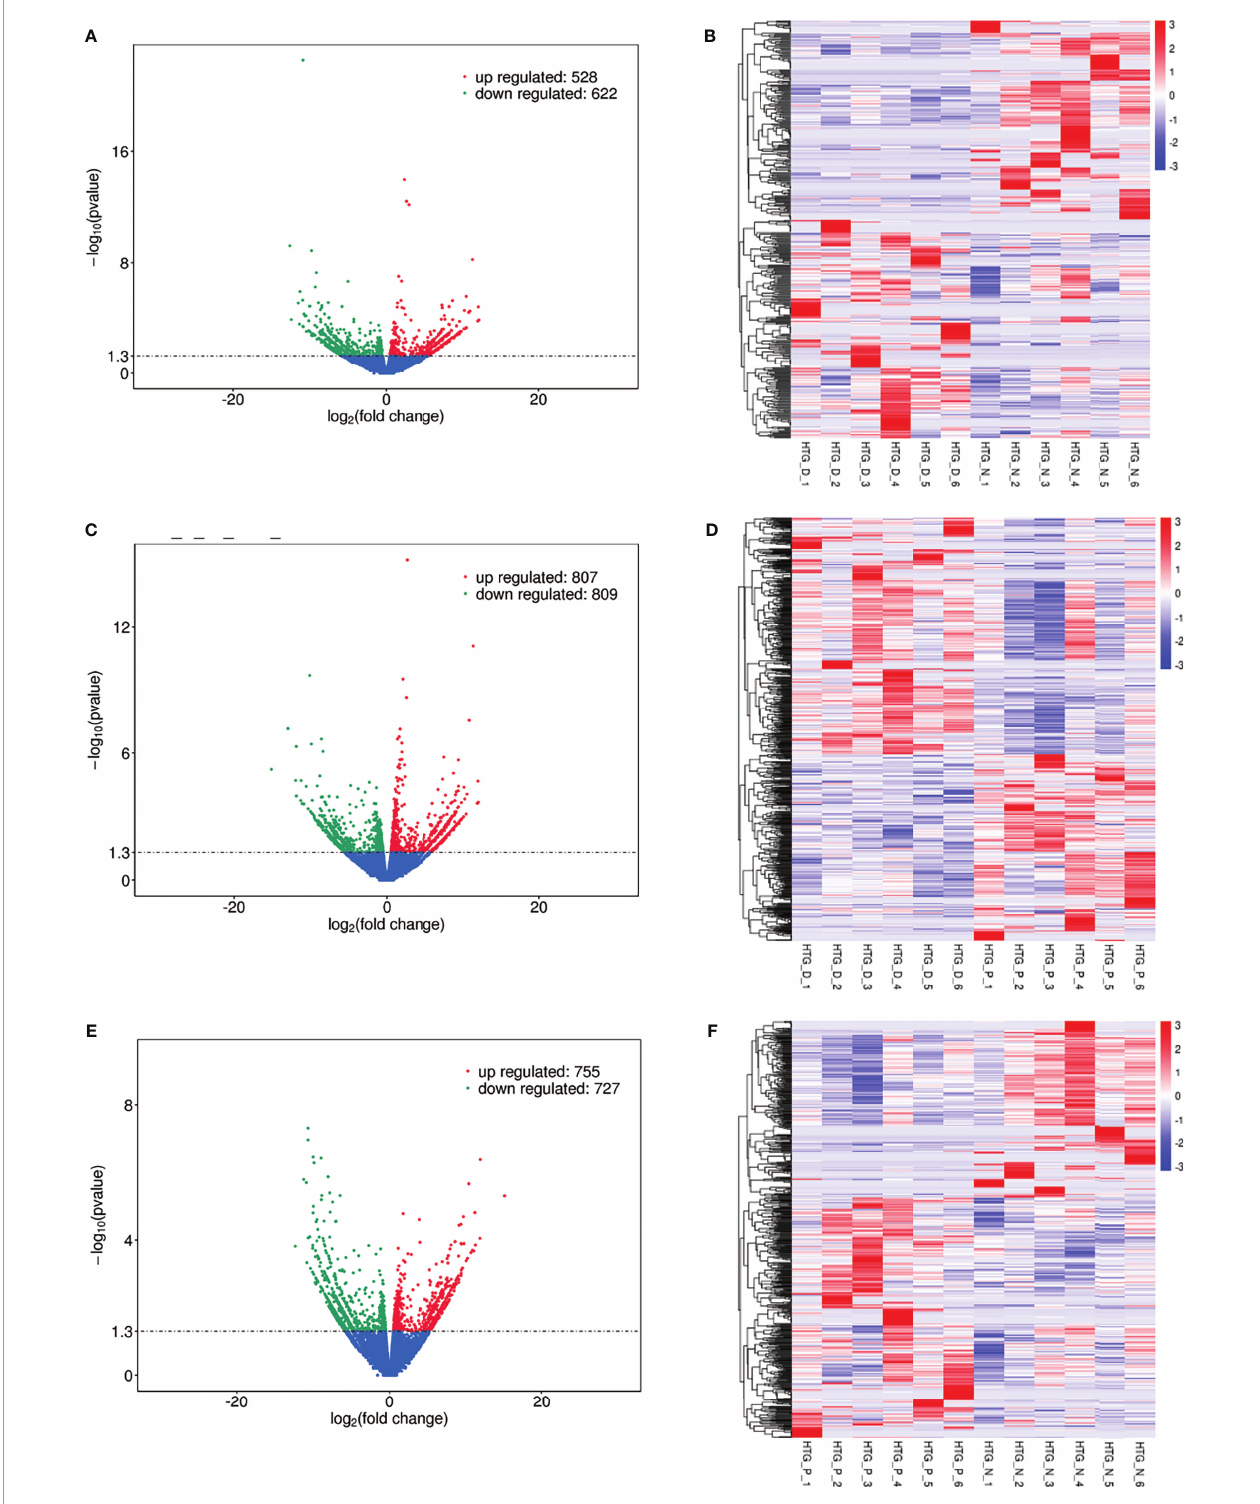
FIGURE 4 | Differentially expressed lncRNAs in (A) T2DM versus normal controls, (C) T2DM versus prediabetes and (E) prediabetes versus normal controls with volcano plot, and (B, D, F) represented the heatmap plot for above groups, respectively.